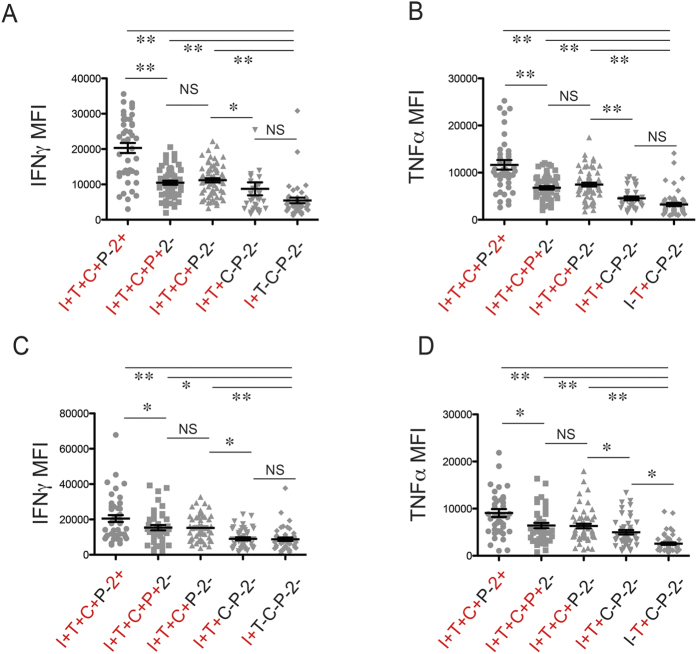
Polyfunctional T cells exhibit enhanced effector functions.Five CMV-pp65-specific functional subsets within CD8 + (A,B) or CD4 + (C,D) T cells were compared with respect to their mean fluorescence intensity (MFI) of TNFα and IFNγ staining. I, IFNγ; T, TNFα; C, CD107a; P, perforin; 2, IL-2. (A,B) In CD8 + T cells, the I + T + C + P-2 + subset displayed the strongest staining for IFNγ and TNFα when compared with the I + T + C + P + 2- and the I + T + C + P-2- subset. The dual functional, I + T + C-P-2- subset and the monofunctional, I + T-C-P-2- or I-T + C-P-2- subset produced even lower levels of IFNγ and TNFα. (C,D) Higher MFIs for IFNγ and TNFα in polyfunctional subsets were also observed in CMV-specific CD4 + T cells. The comparisons were carried out individually by paired Student’s t-test. The threshold for statistical significance was corrected following the Bonferroni method. NS: non-significant; *p value < 0.007; **p value < 0.0007.